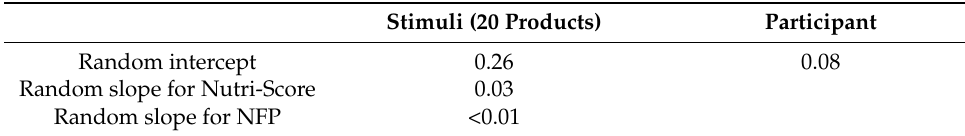
Table 5. ICC of the random effect terms.